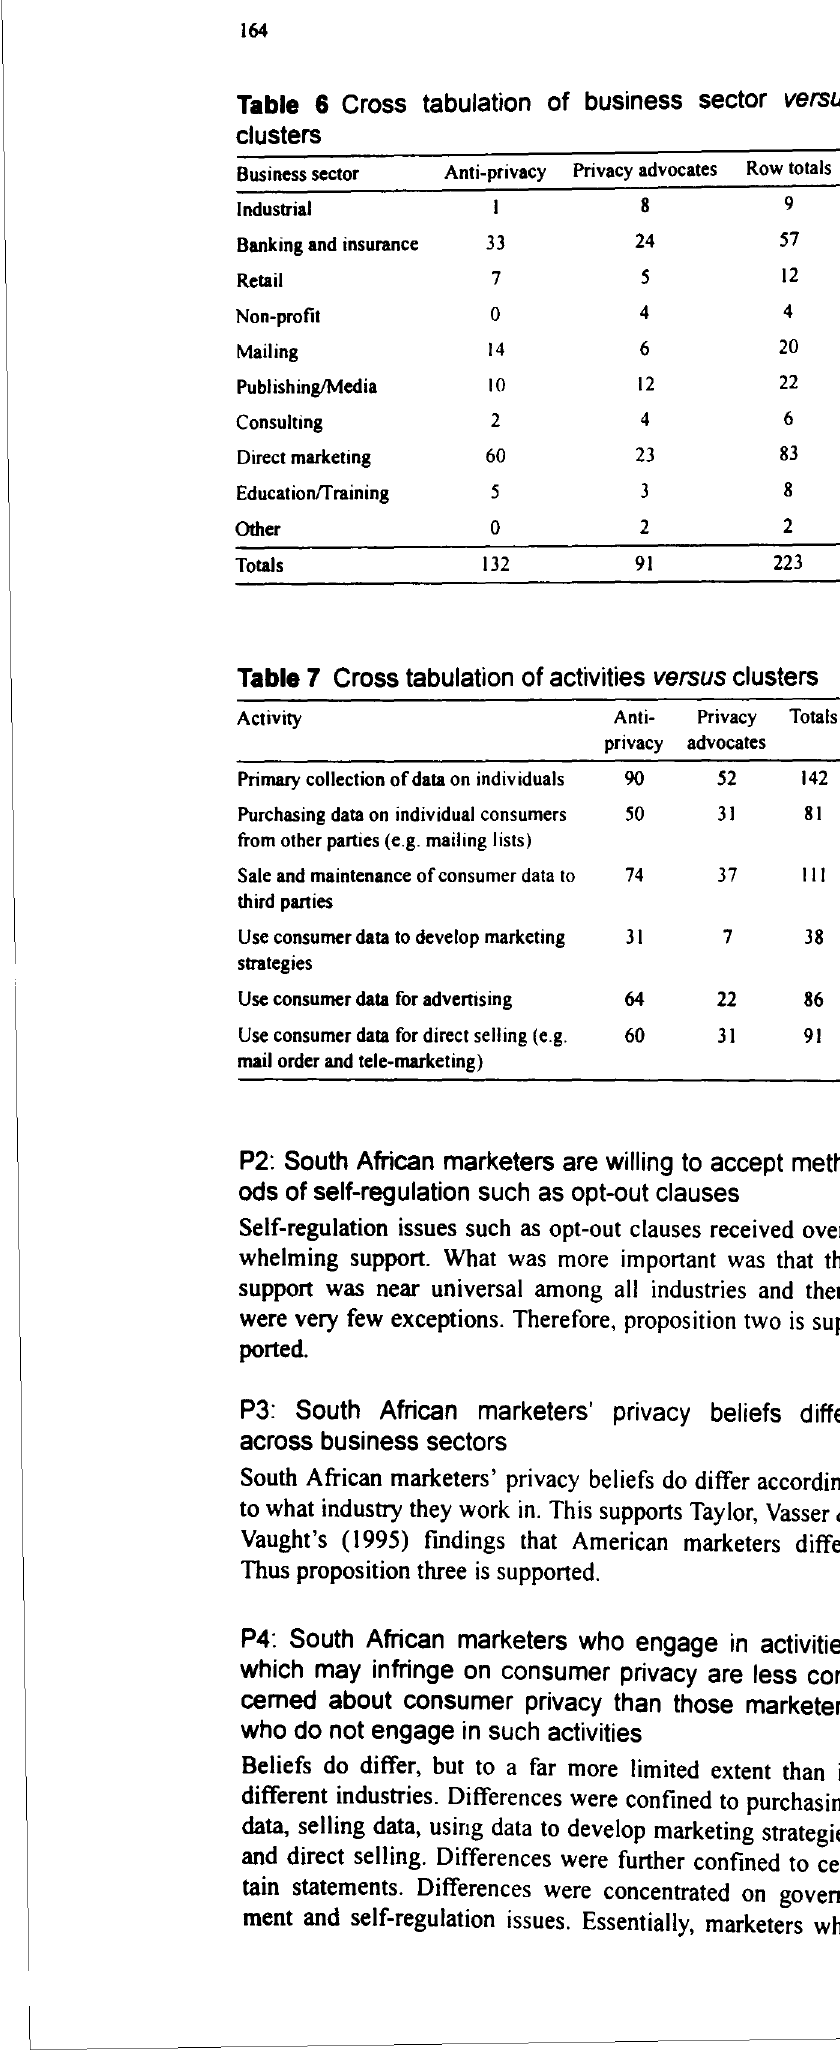
Table 7 Cross tabulation of activities versus